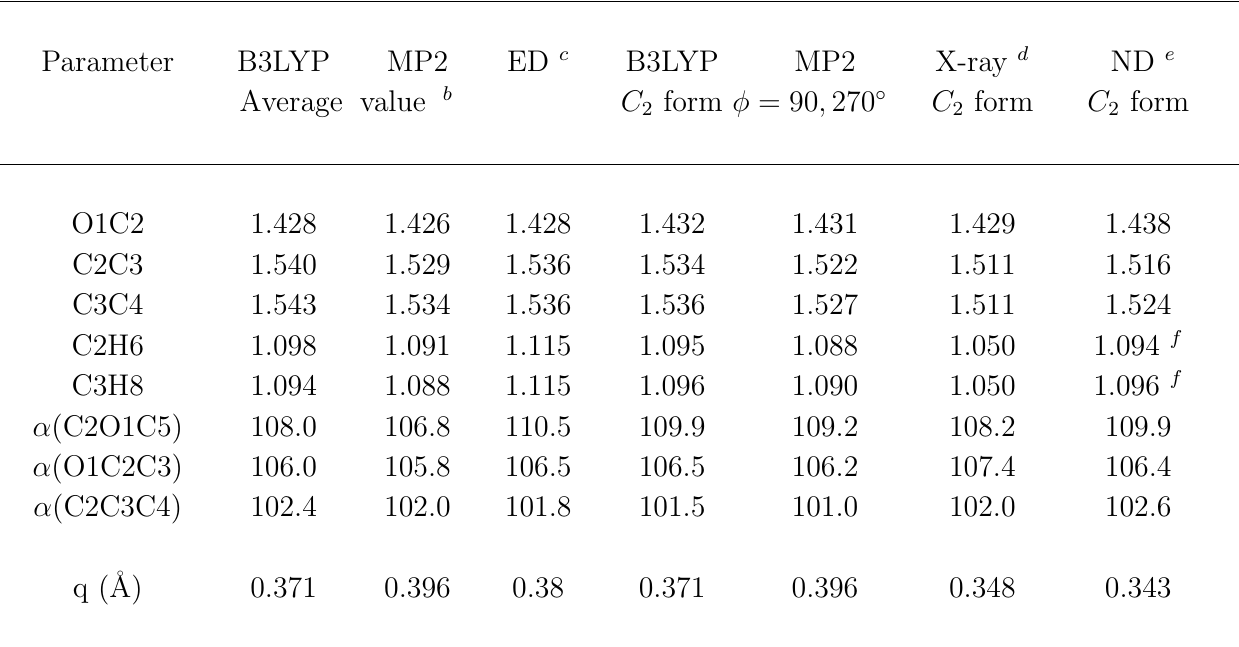
Table 3. Average geometrical parameters of THF calculated at B3LYP/6-31G(d,p) and MBPT(2) /cc-pVTZ.